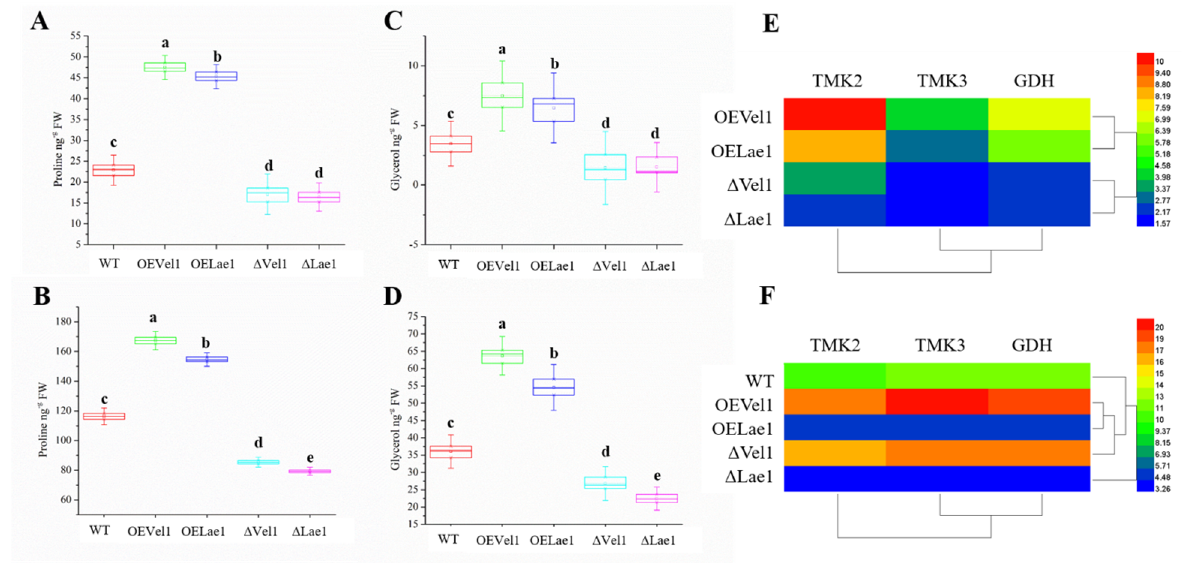
Figure 2. Osmolyte accumulation of T. asperellum WT, OE Vel1 , OE Lae1 , ∆ Vel1 , and ∆ Lae1 under salinity stress. Accumulation of proline under ( A ) normal and ( B ) saline conditions. Accumulation of glycerol under ( C ) normal and ( D ) saline conditions. The relative expression of MAPK signal transduction (TMK2 and TMK3) and GDH under ( E ) normal and ( F ) saline conditions as the fold ratio between the WT grown under normal conditions. Boxes with different letters represent a statistically significant difference from each other at the level of p < 0.05 based on ANOVA.